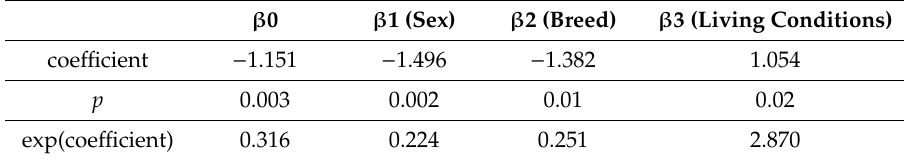
Table 3. Logistic regression coe ffi cients and corresponding p